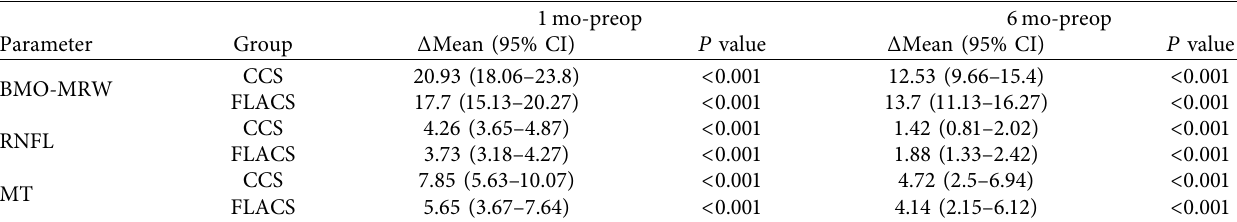
Table 3: Diference between postoperative and preoperative values of BMO-MRW, RNFL and MT in CCS and FLACS groups. 1 mo-preop 6mo-preop Parameter